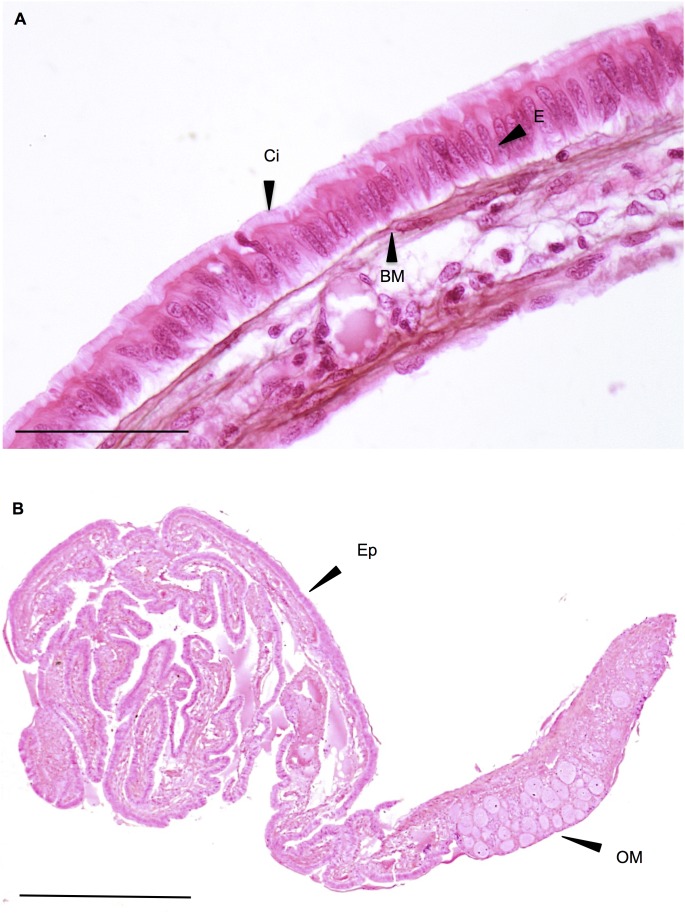
Proliferative oviduct-like epithelioid structure.All-male rainbow trout testis at 136 dpf exposed chronically to 1 and 10 µg/L EE2 for 76 days. HES. Ci: cils; E: columnar epithelial cells; BM: basement membrane; Ep: epithelioid; OM: ovarian-like morphology. Scale bars A = 50 µm; B = 500 µm.